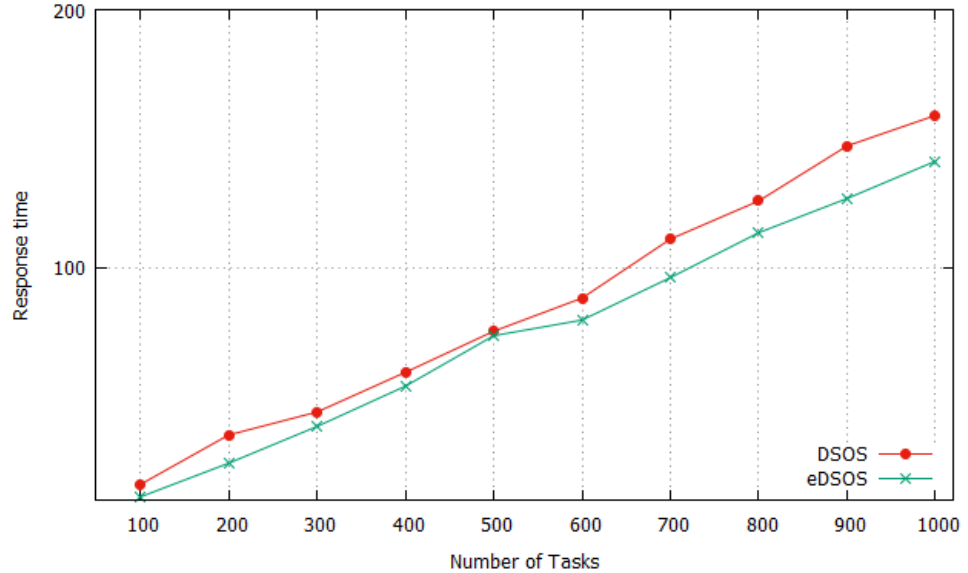
Figure 7. Response time for the dataset with the normal